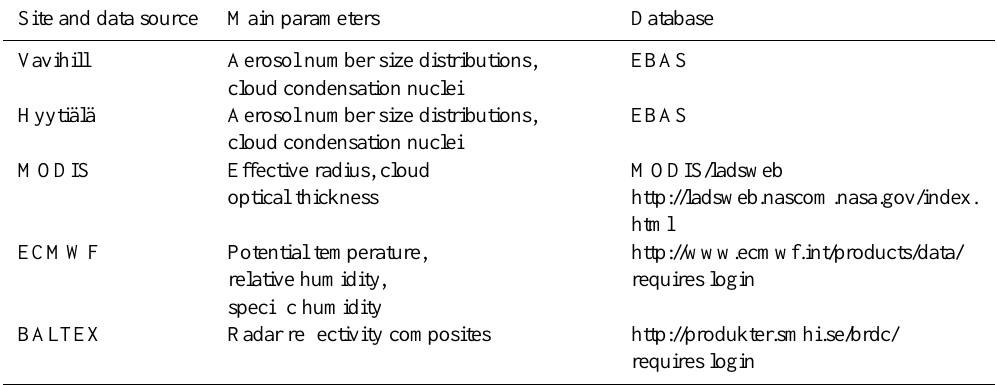
Table 1. Summary of the data sets used in this